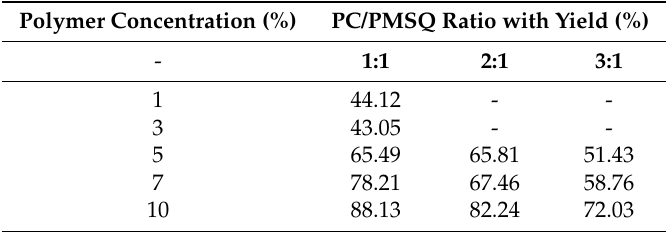
Table 1. The embedment yield of the PMSQ particles on the surface of PC microspheres at different PC concentration and PC/PMSQ